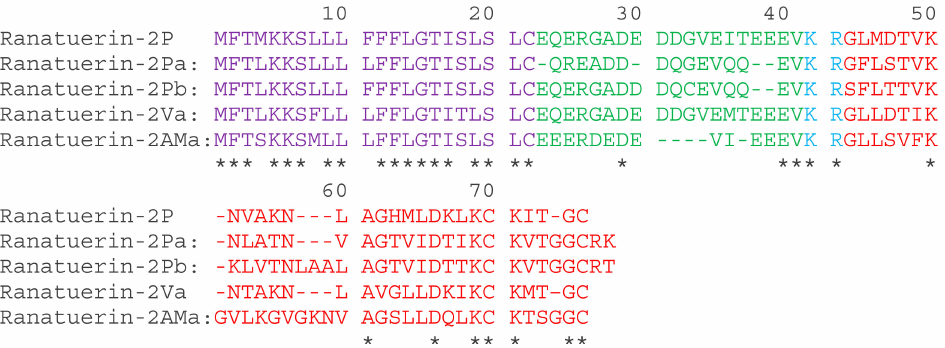
Figure 1. The translated open-reading frame amino acids sequences of ranatuerin-2 peptides from di ff erent species of frogs. The sequences of mature peptides in are labelled in red. The sequences of signal peptide are labelled in purple. Asterisks indicate the identical amino acid residues. The acid spacer peptide regions are labelled in green. The processing sites of the precursor for releasing mature peptides are labelled in blue. Gaps (dashed line) were introduced to optimise the